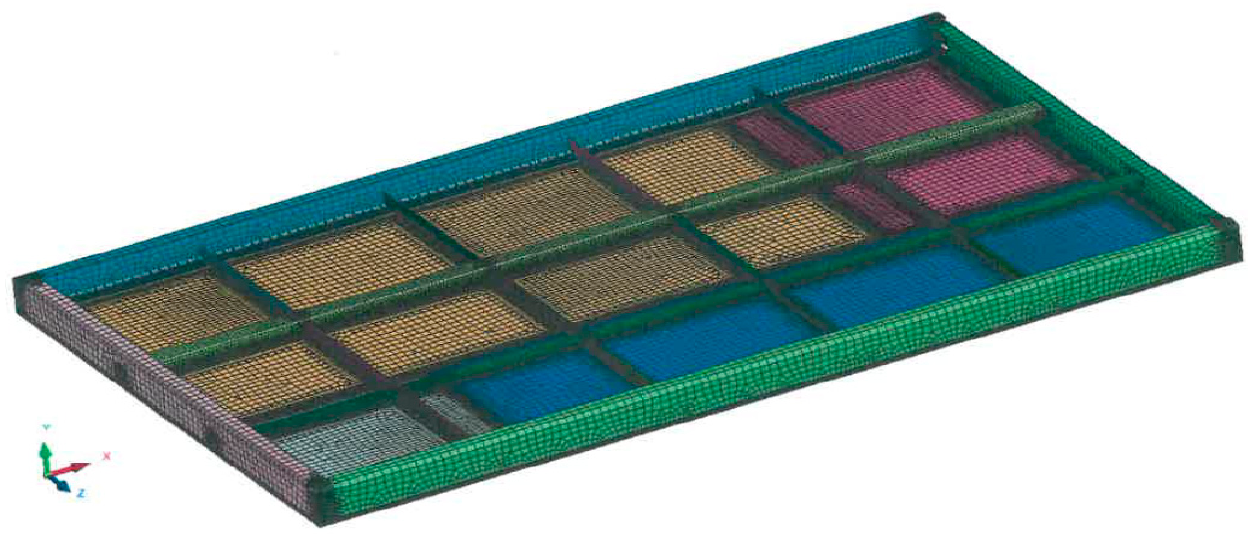
Figure 2. CAD and FEM model of the industrial furnace wall panel.